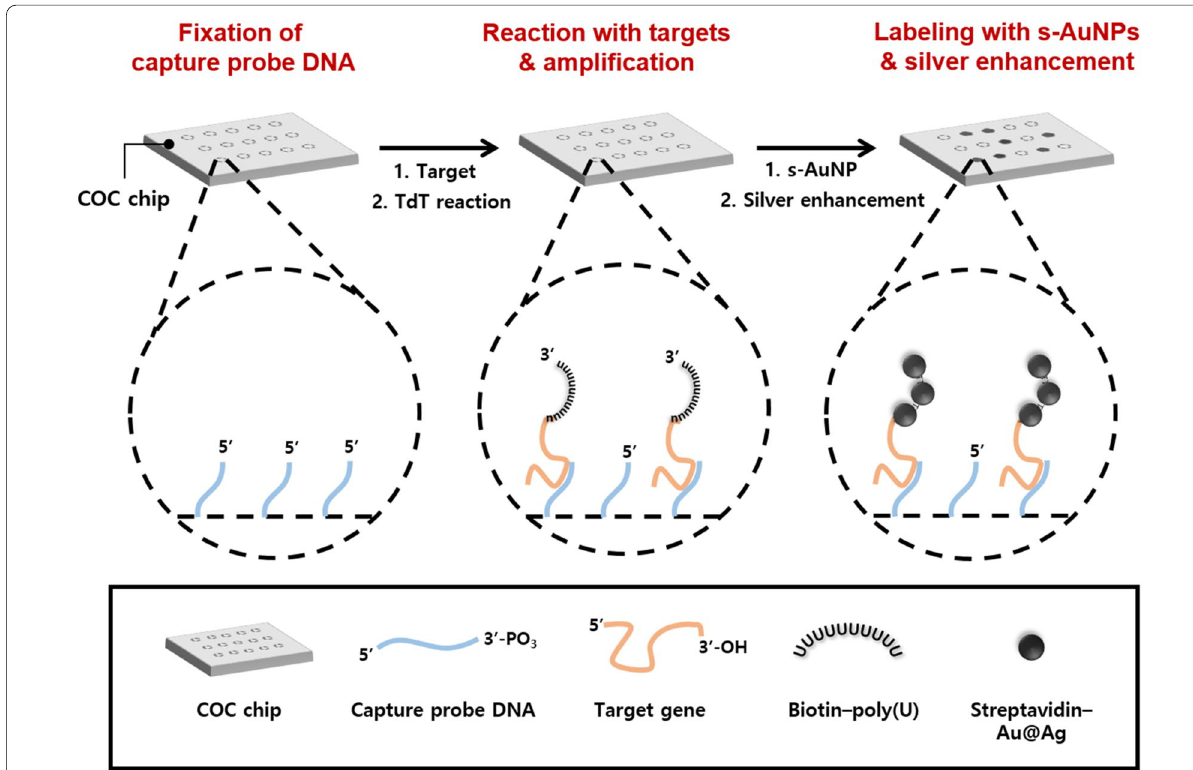
Fig. 1 Schematic illustration of the microarray‑based detection method for visually identifying pathogenic